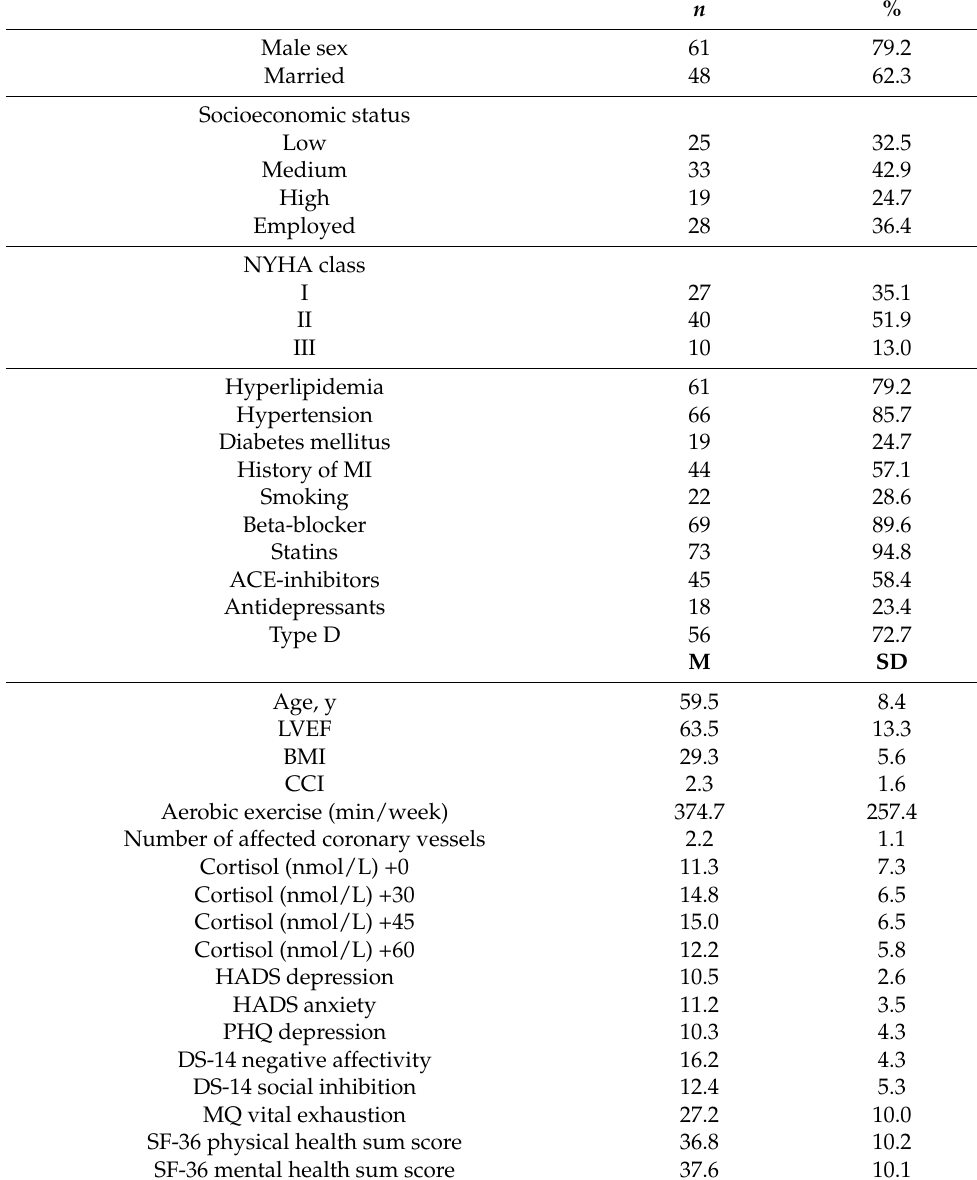
Table 1. Baseline